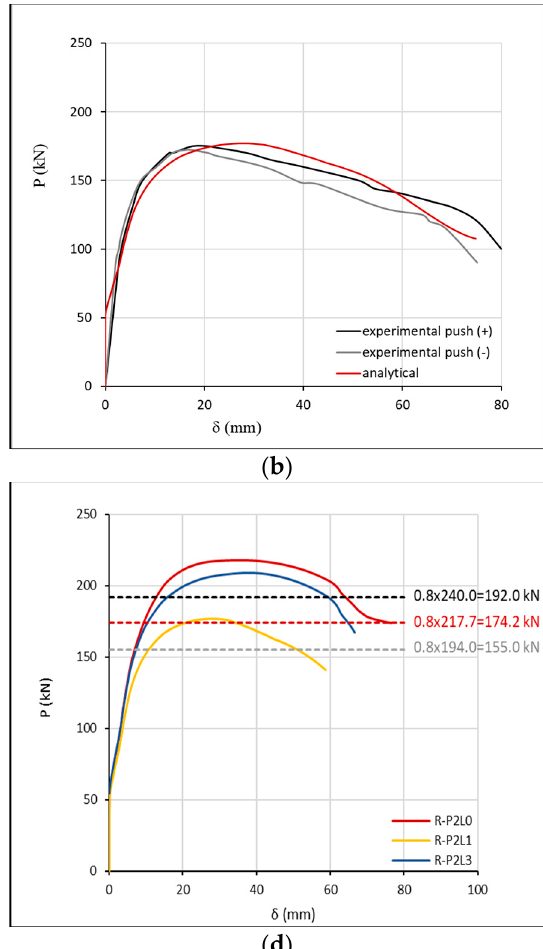
12.51 Table 1 cites the analytical (derived from FE analyses) and experimental results of columns without lap splices or with bar lap lengths of 15 d bL and 30 d bL , externally confined with CFRP jackets. It presents and compares the maximum and ultimate lateral force (P max , P u = 0.80 P max ) and the corresponding displacements ( δ Pmax , δ Pu ). The parameter used to compare the analytical with the experimental values in this study is absolute divergence (AD), also known as absolute error (AE), and it is defined in Equation (4). AD= |a anal. -a exp. (cid:3627) a exp.